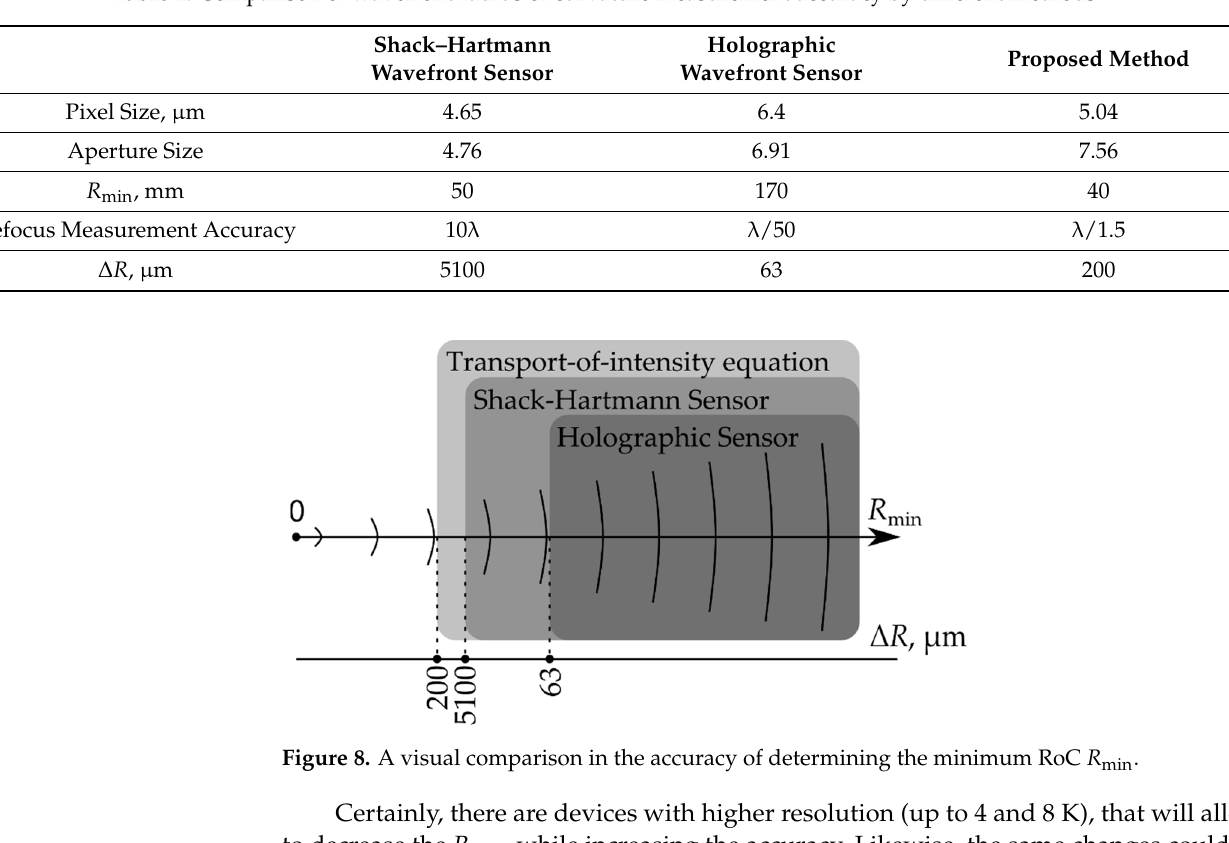
Table 1. Comparison of wavefront radius of curvature measurement accuracy by different methods.